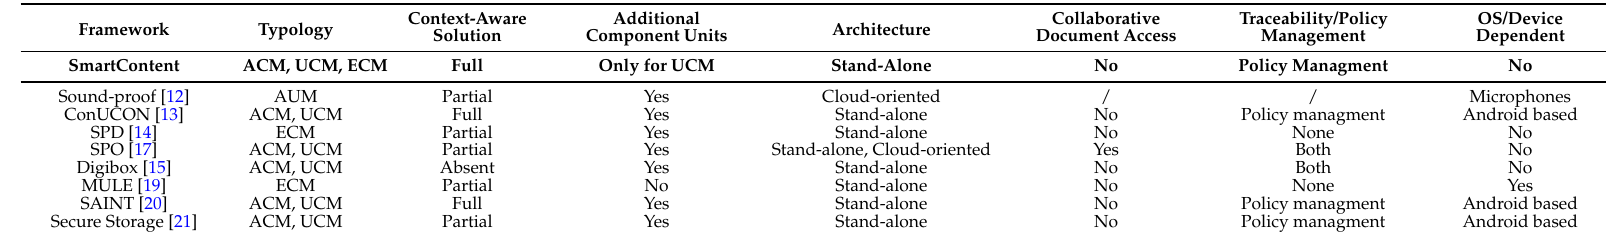
Table 1. Comparison of the cited security